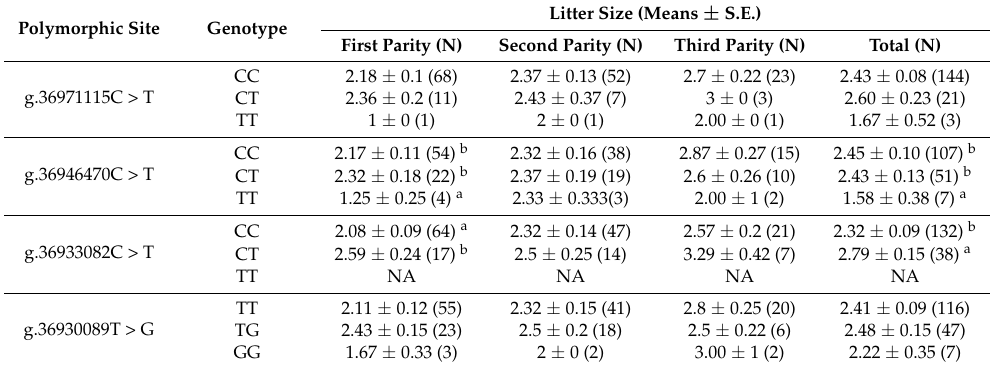
Table 3. Litter size and standard error of STH ewes in different parities for each genotypes. Polymorphic Site Genotype